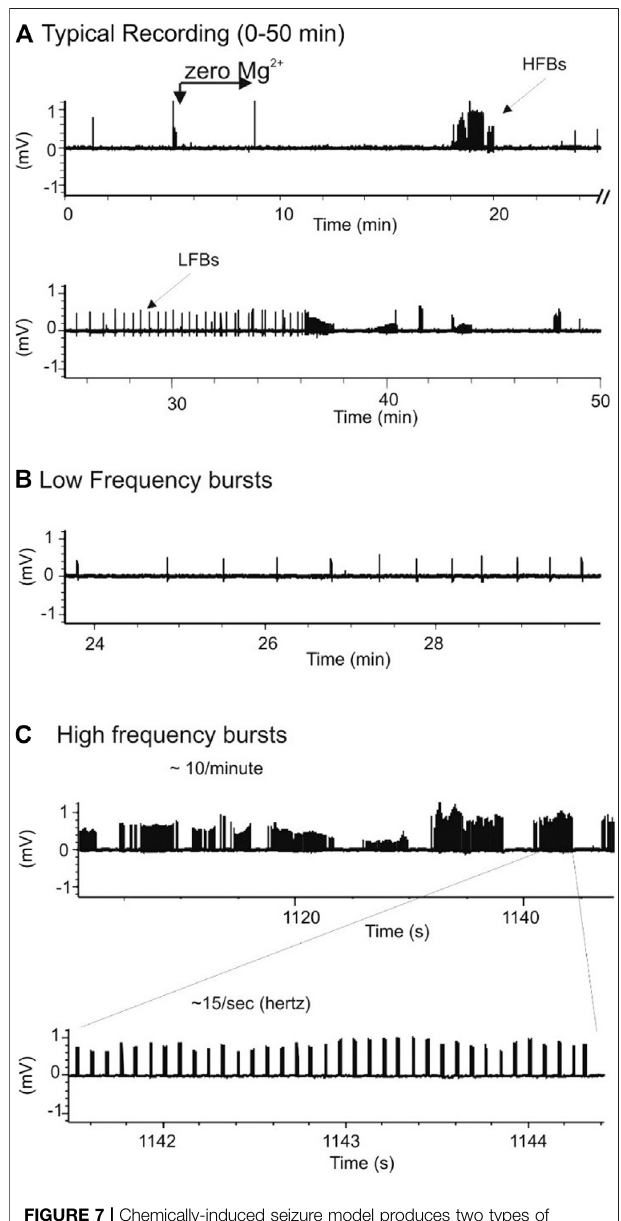
FIGURE 7 | Chemically-induced seizure model produces two types of spontaneous response. (A) : Typical recordings of bursts in a hippocampal slice exposed to zero-Mg 2+ high K + medium. (B,C) : Expanded scales from A showing two types of spontaneous seizure activity induced by zero- Mg 2+ highK + medium:lowfrequencyburst(LFB)- B andhighfrequencybursts